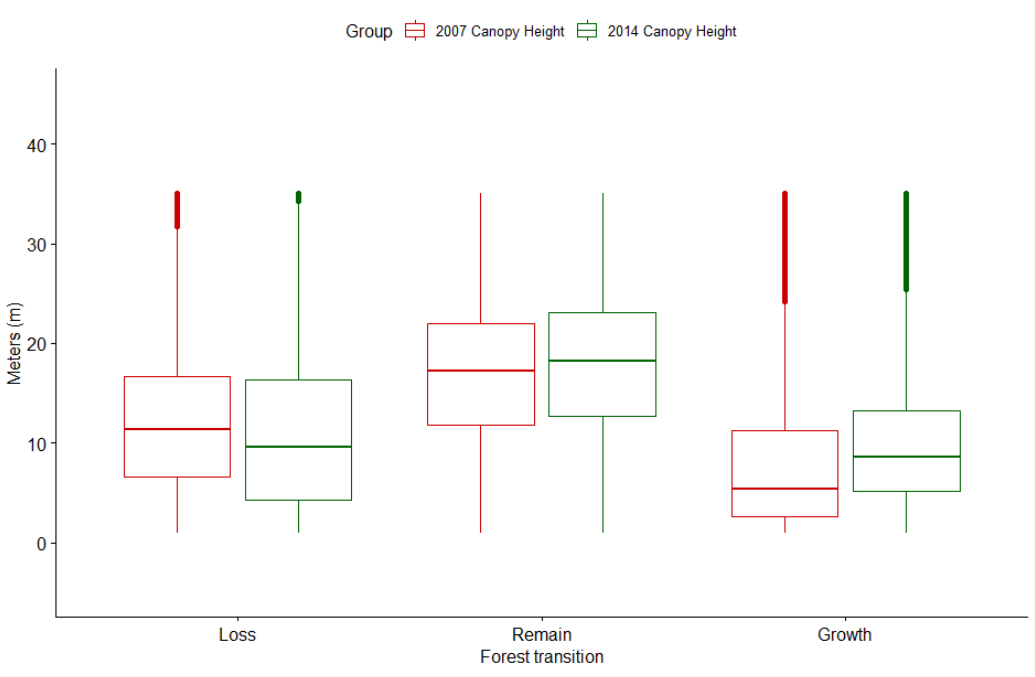
Figure 5. Comparison of canopy height from 2007 and 2014 across the forest transition classes.